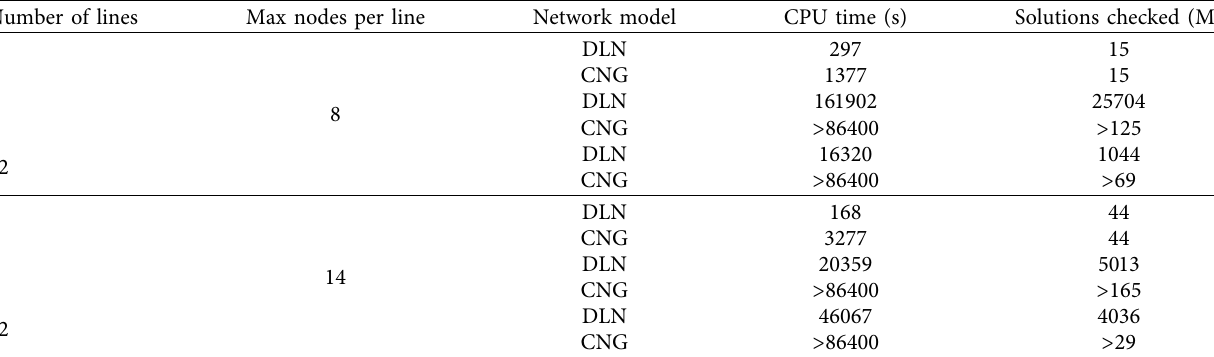
Table 9: Impact of the Direct Link Network instead of the Change and Go network representation on the exact algorithm. Number of